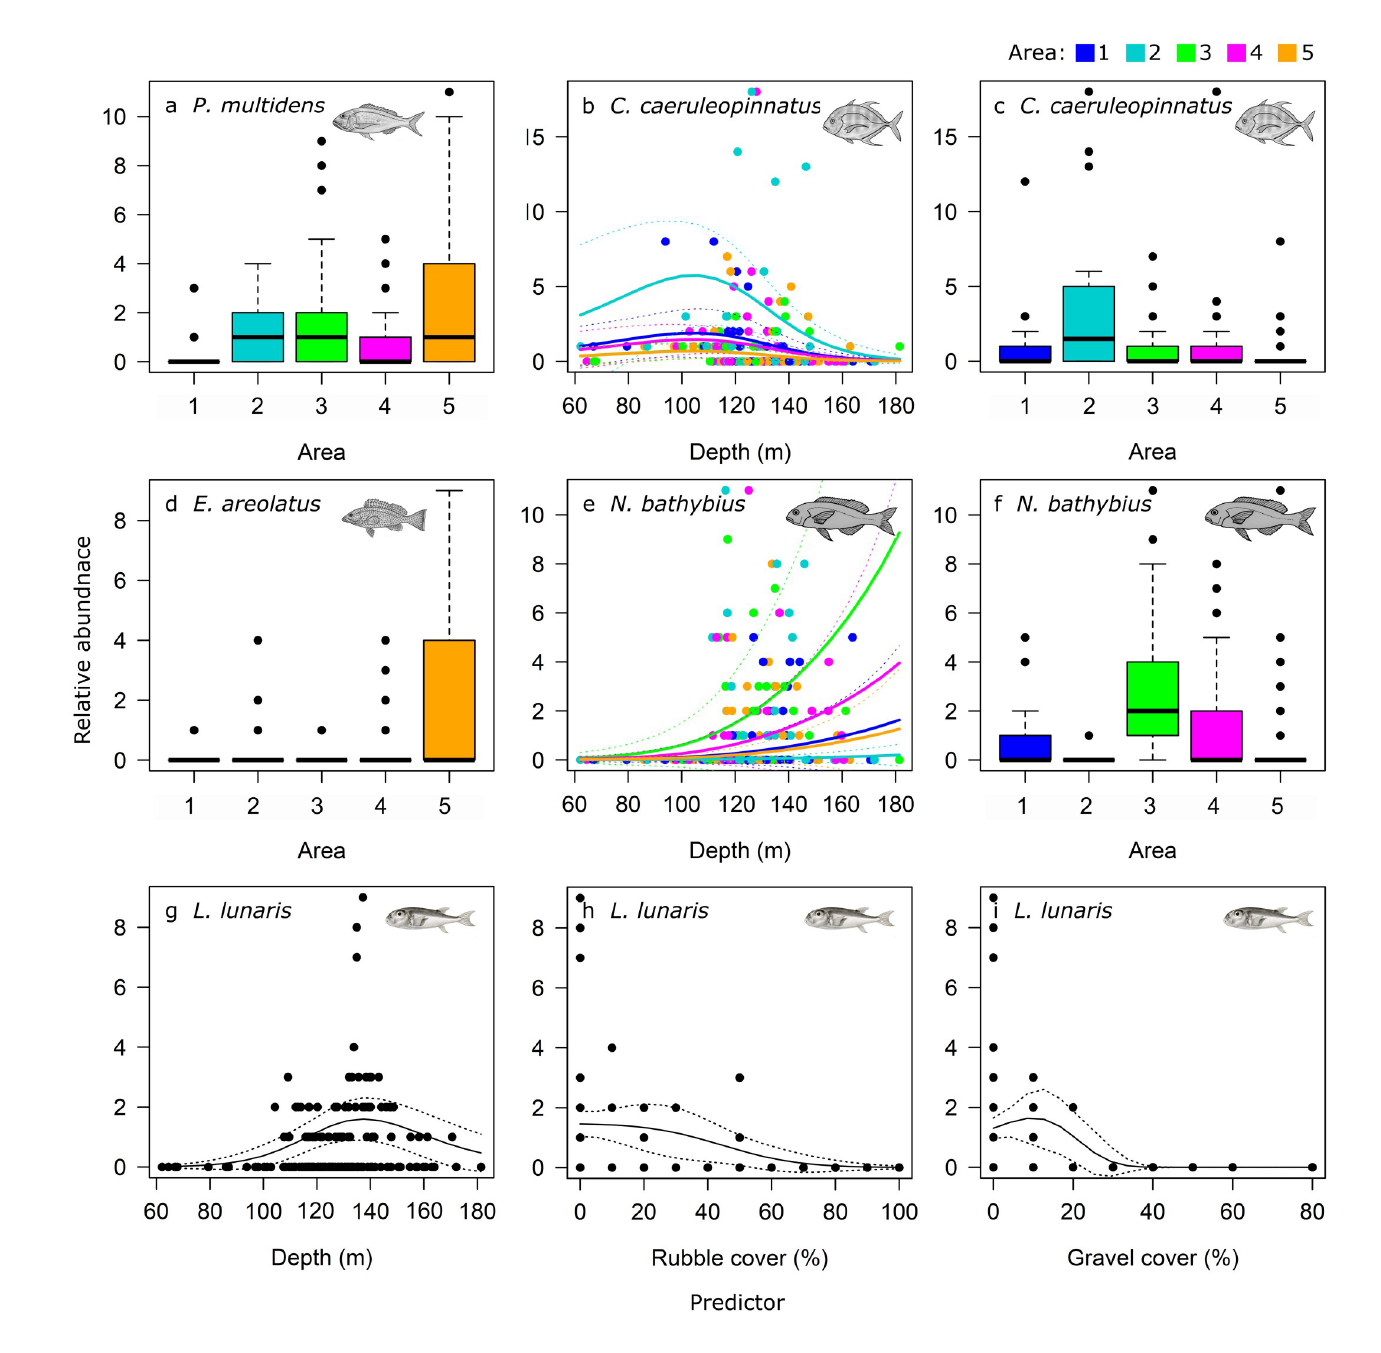
Fig 6. GAMM predicted trends in relative abundance (MaxN) per BRUVS deployment of common species: Pristipomoides multidens (a); Carangoides caeruleopinnatus (b, c), Epinephelus areolatus (d), Nemipterus bathybius (e, f) and Lagocephalus lunaris (g, h, i), by Area, depth and proportion of rubble and gravel cover from best models. Lines indicate the fit of the best-approximating model with 95% confidence intervals (dotted lines). a-f are coloured by Area 1–5.